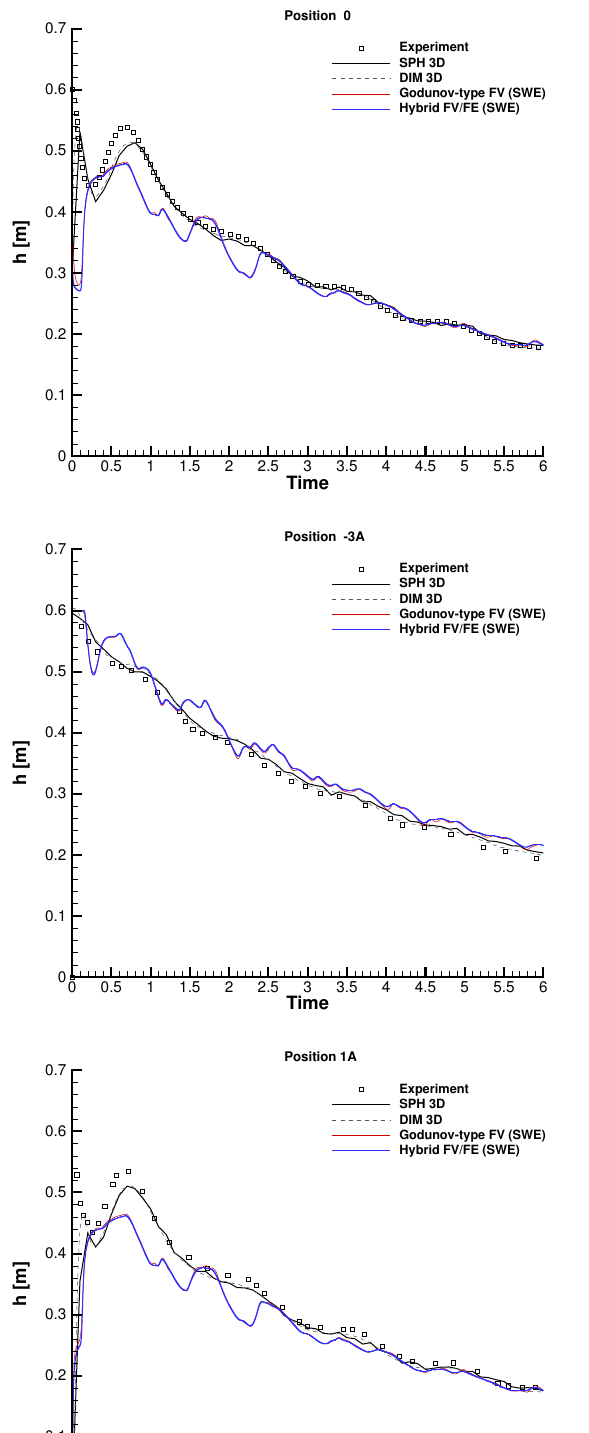
Figure 24. Time evolution of the free surface elevation obtained at wave gauges 0, dambreak over a plane dry bed. Hybrid FV/FE scheme applied to the shallow water equations (blue line); experimental results of Fraccarollo and Toro [102] (squares); explicit Godunov-type finite volume scheme (red line); fully nonhydrostatic 3D SPH scheme [103] (black dashed line); 3D diffuse interface method [104] (black